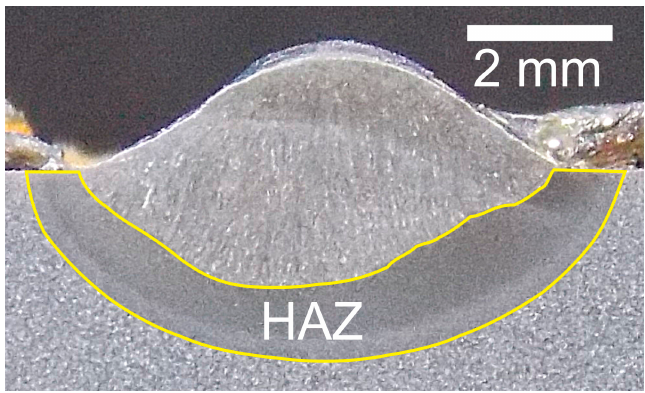
Figure 8. Test specimen optimized in relation to the HAZ area.